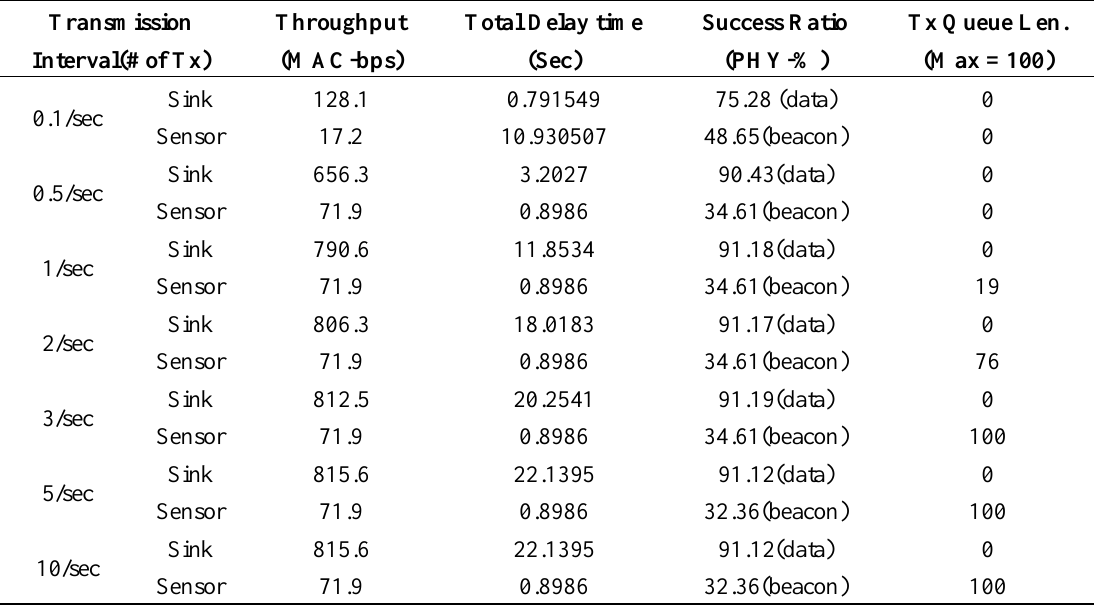
Table 9. Performance of